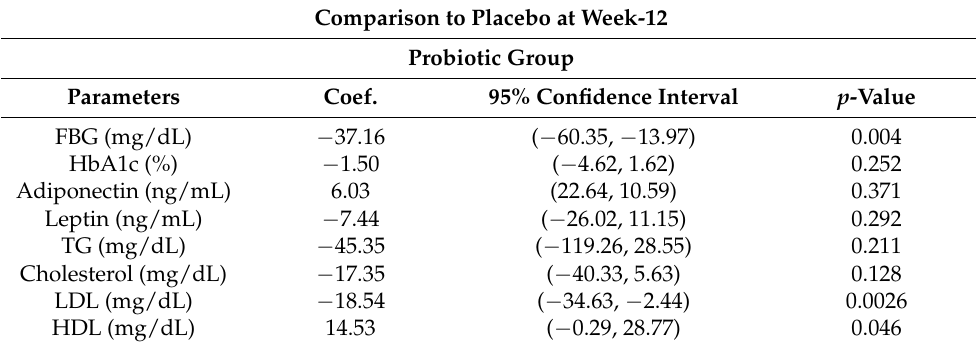
Table 3. The differentiation of blood levels of FBG, HbA1c, adiponectin, leptin and lipid profiles between L. paracasei HII01 treatment and placebo group at the end of study.